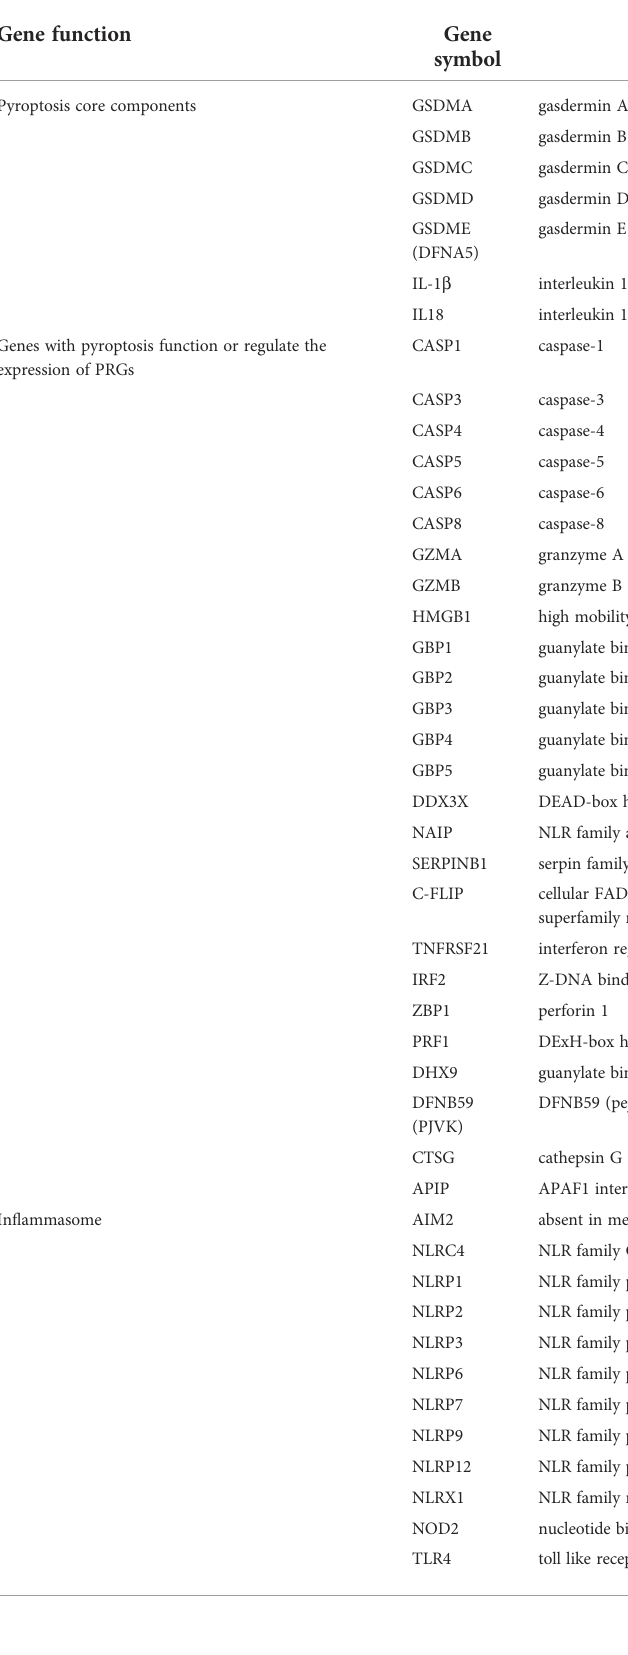
TABLE 1 Compilation of pyroptosis-related